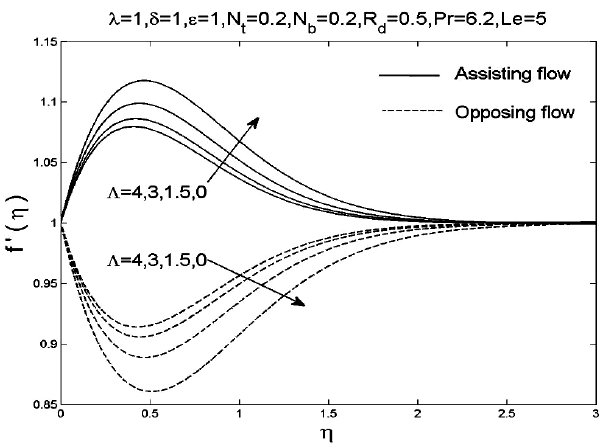
Fig. 2. The effect of the constant magnetic/porous medium param- eter Λ on the velocity profiles ( ) f η′ .